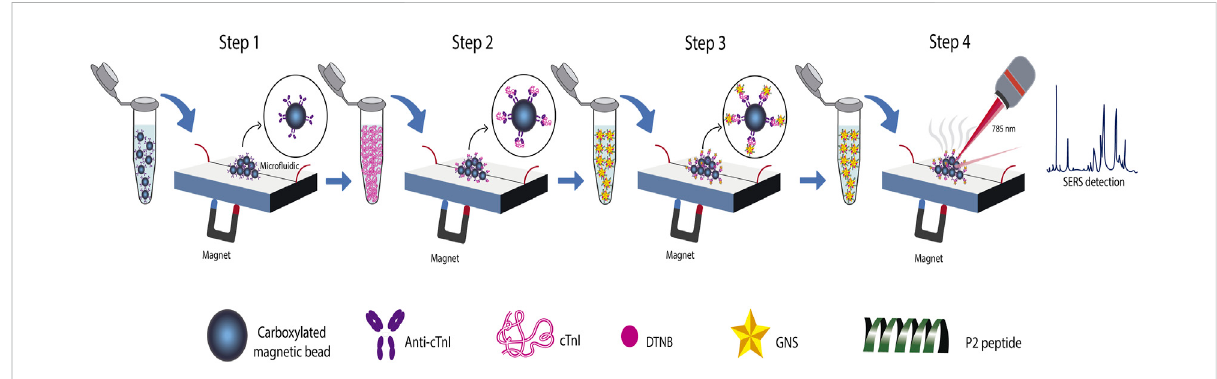
FIGURE 10 Schematic representation of the sandwich immunoassay integrated in an active micro fl uidic device for the quanti fi cation of cTnI and neuropeptide Y, adapted from Wen et al.